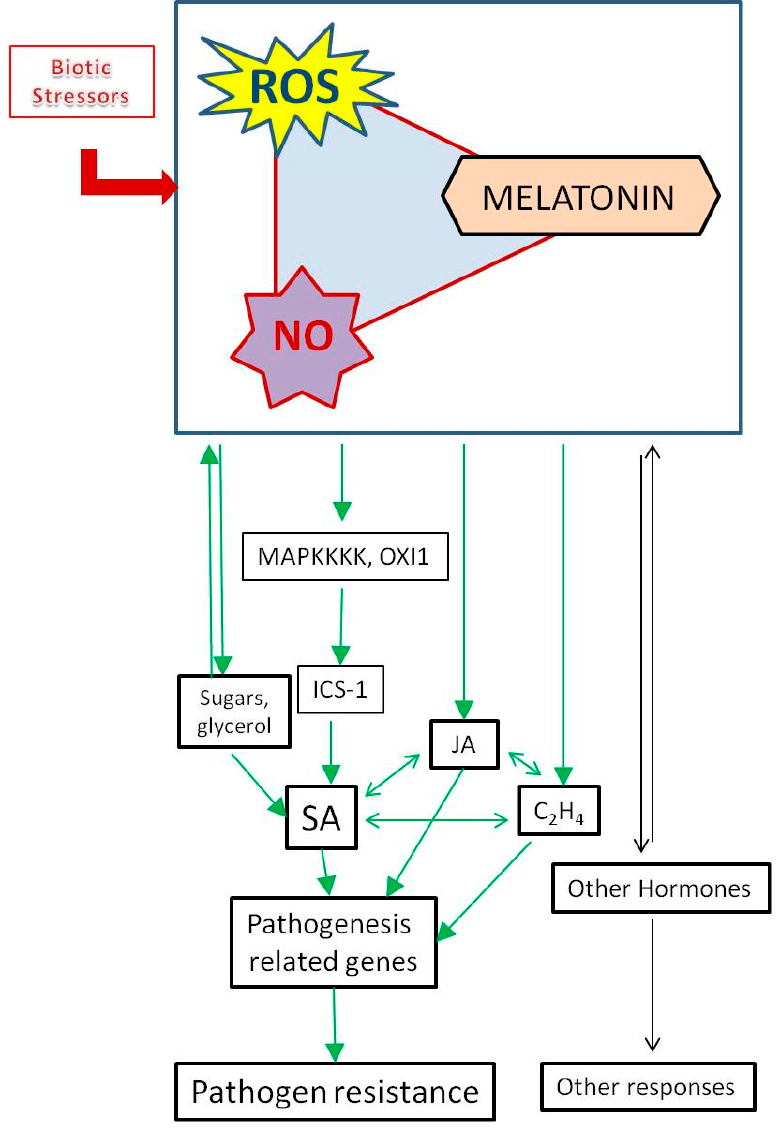
Figure 3. Model of ROS/NO/melatonin action on biotic stress responses (pathogen resistance).